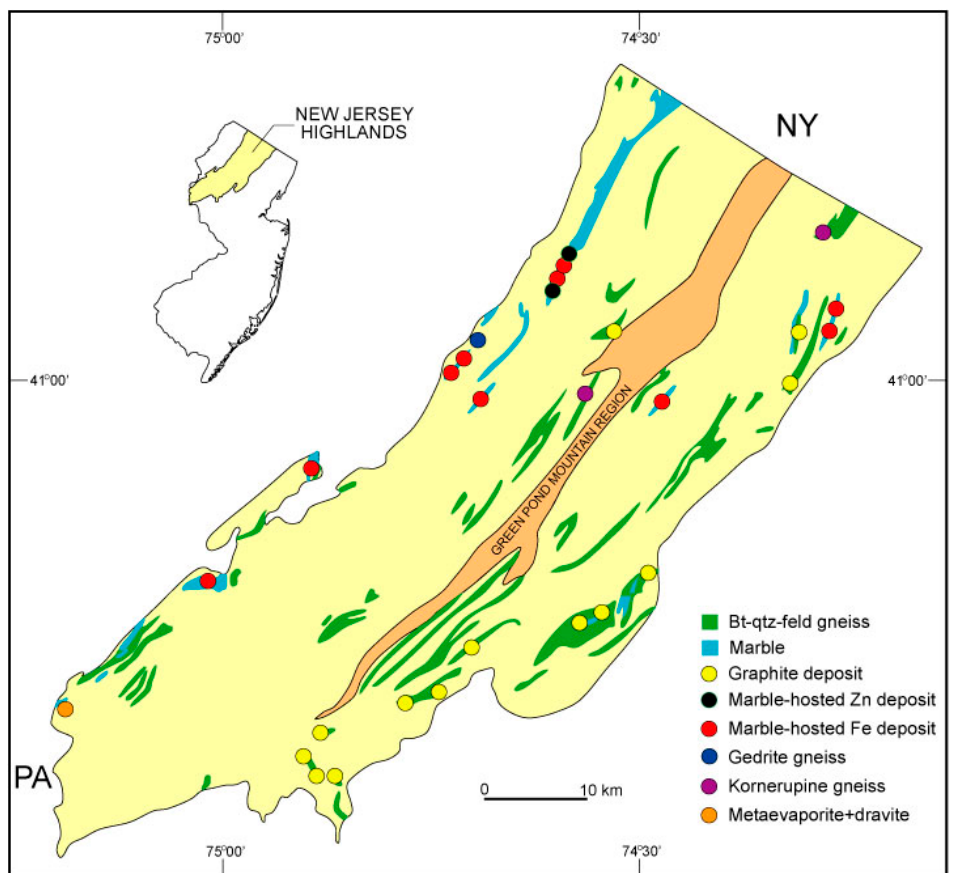
Figure 9. Map showing the distribution of marble in the New Jersey Highlands that hosts zinc deposits at Franklin and Sterling Hill and regional low-Ti magnetite deposits, biotite gneiss that hosts graphite deposits and the kornerupine + prismatine locations of this study, gedrite gneiss, and possible metaevaporite deposit. Note the linear trends of marble-hosted magnetite and zinc deposits in the western Highlands and confinement of graphite deposits mainly to the eastern Highlands. Modified from [18,33].